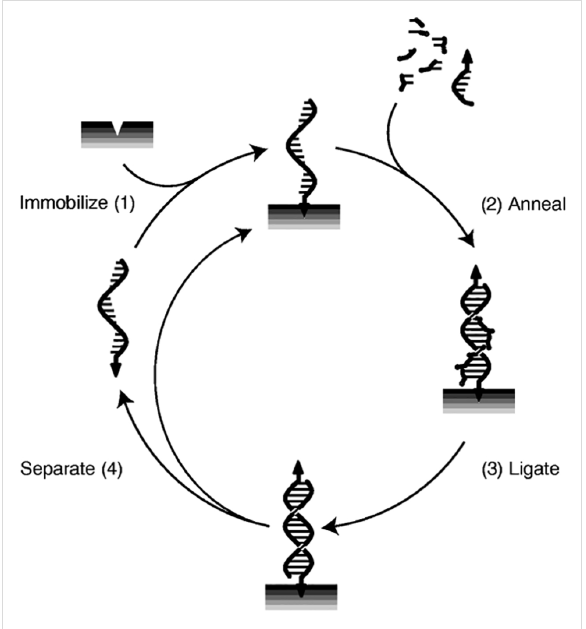
Figure 5: Replication involving the SPREAD technique which prevents product inhibition. (1) A template molecule is immobilized on a solid support and (2, 3) a complementary copy is produced by template- directed replication. Finally the copied strand is (4) released from the template and is in turn immobilized [33].